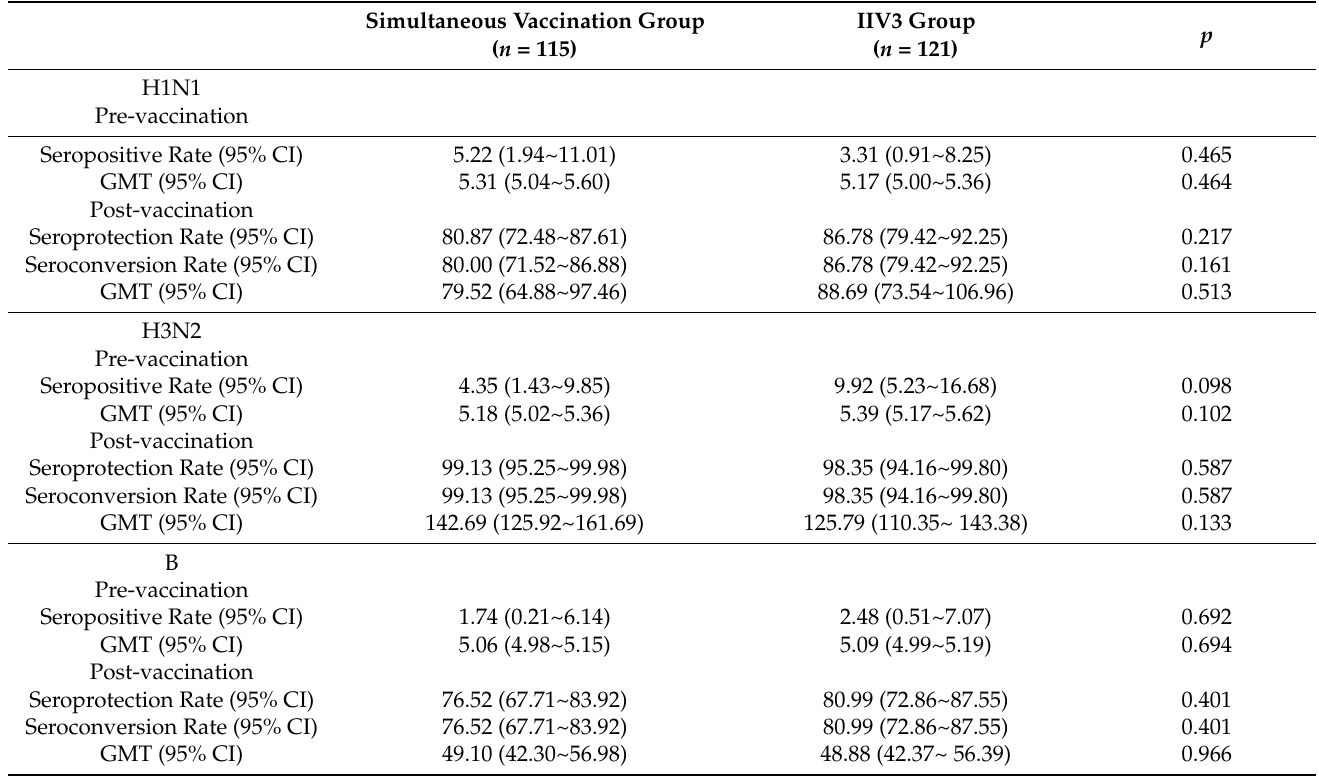
Table 3. Antibody responses to influenza virus in the per-protocol